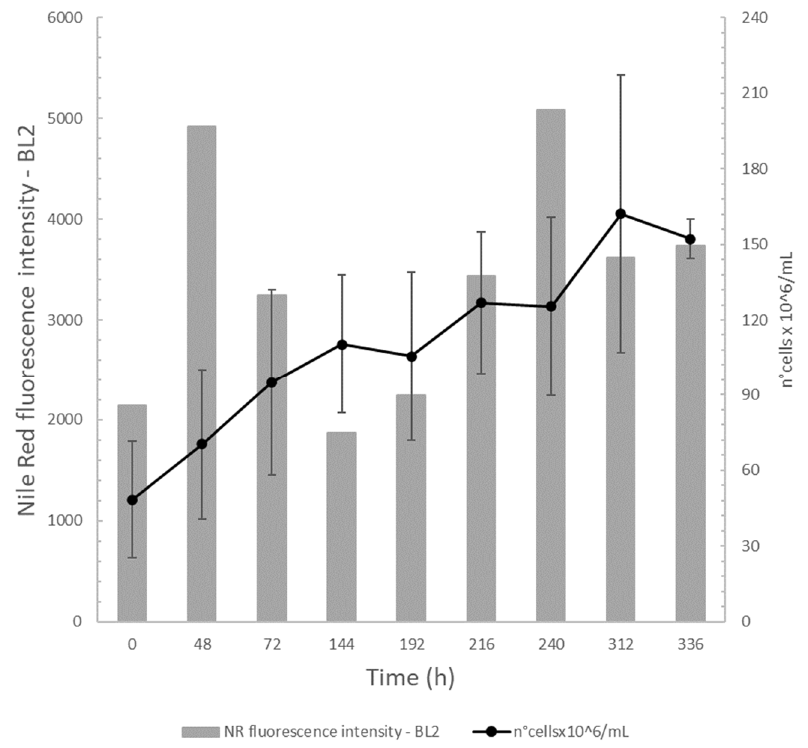
Figure 6. Combination chart of number of cells × 10 6 /mL ( line ) and Nile red fluorescence intensity (BL-2) ( bars ) of yeast cells for up-scale batch cultures. For the determination of the number of cells × 10 6 /mL, data are mean values of three different measurements, and bars represent standard deviations, while for Nile red fluorescence intensity, data represent a representative experiment (from three independent experiments) performed in a single run.